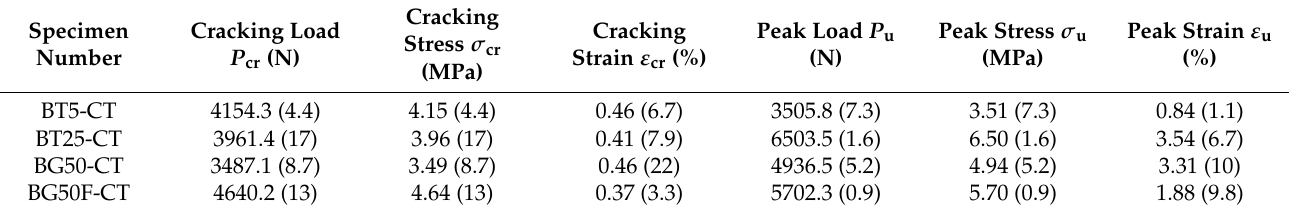
Table 3. Tensile test results of the BGRM before exposure to elevated